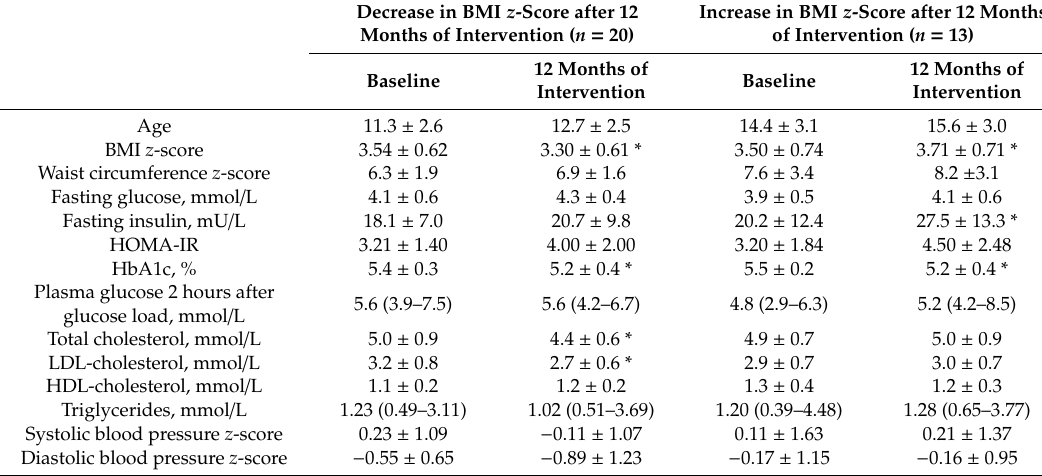
Table 2. Characteristics of the study participants at baseline and after 12 months of lifestyle intervention stratified for change in BMI z